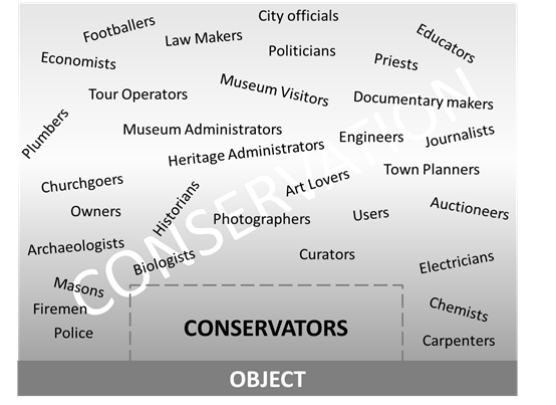
Figure 1. The relative positions of various actors in conservation, in relation to the object of conservation (or the building and site, in the current author’s interpretation), redrawn and amended, slightly, from [1] (with permission of the author). Sub ‐ types of scientist can be seen in the population (including arguably Archaeologists). Geologists and petrographers are conspicuous by their absence, indeed scientists in general, however [1] did not intend this as a proscriptive or complete